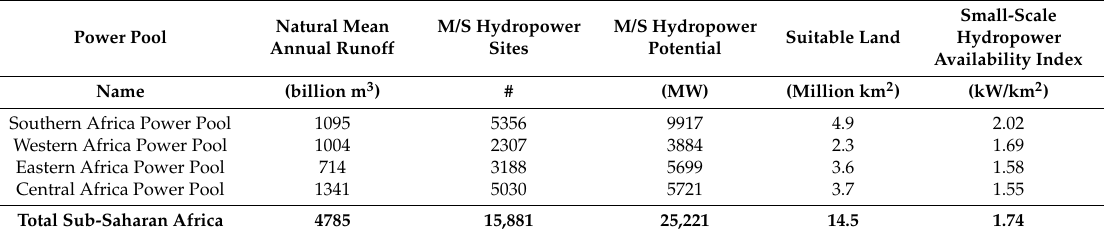
Table 5. Identified small-scale hydropower density per African power